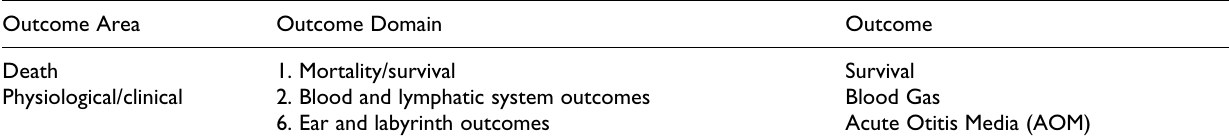
Table 3. Long-list of outcome measures organised according to COMET COS